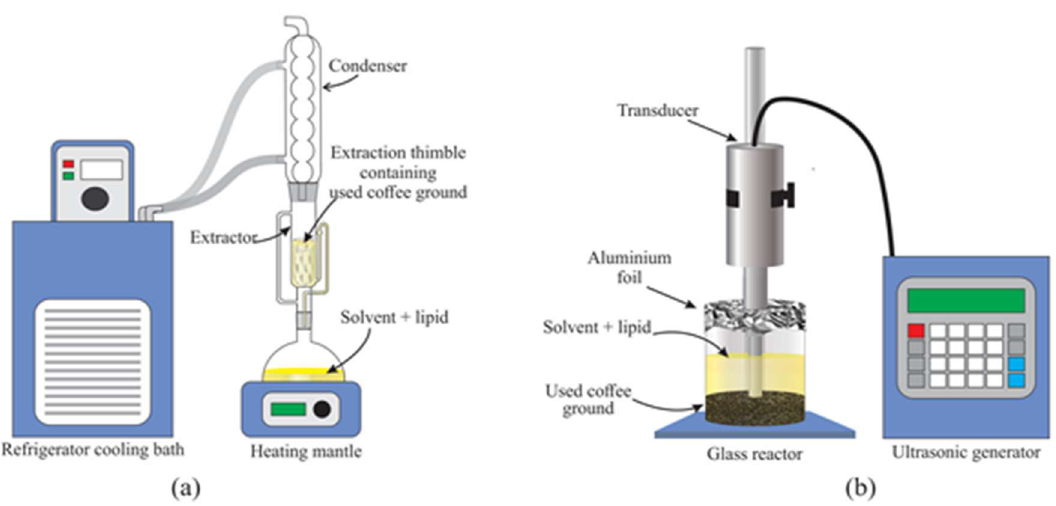
Figure 1. Schematic diagram of ( a ) Soxhlet extraction set-up, ( b ) ultrasonic-assisted extraction setup.